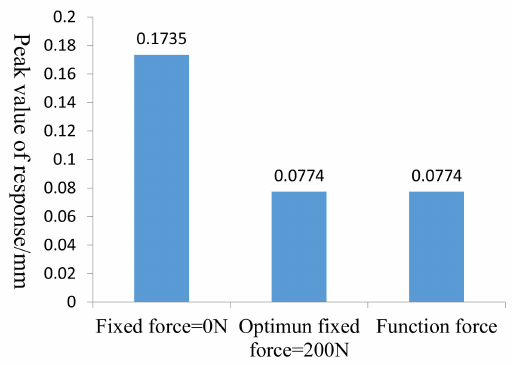
Figure 25. Critical vibration peak value of shafting under di ff erent control